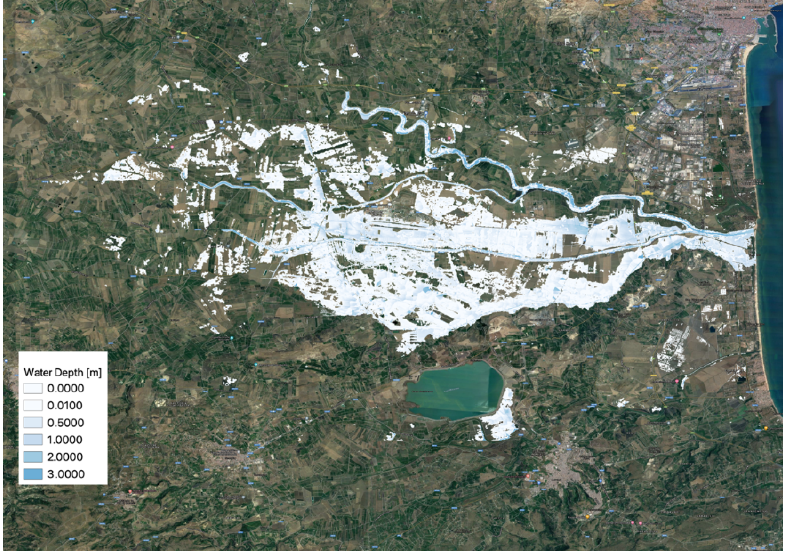
Figure 13. Water depth map obtained for the Catanian floodplain (Sicily) from the merging of TELEMAC-2D and FwDET tool